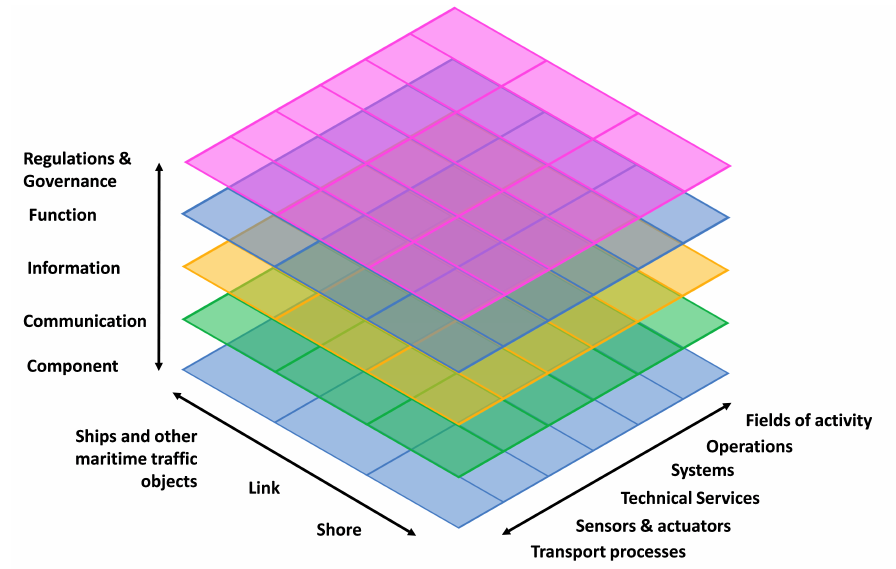
Figure 16. MAF (Maritime Architecture Framework) [83].